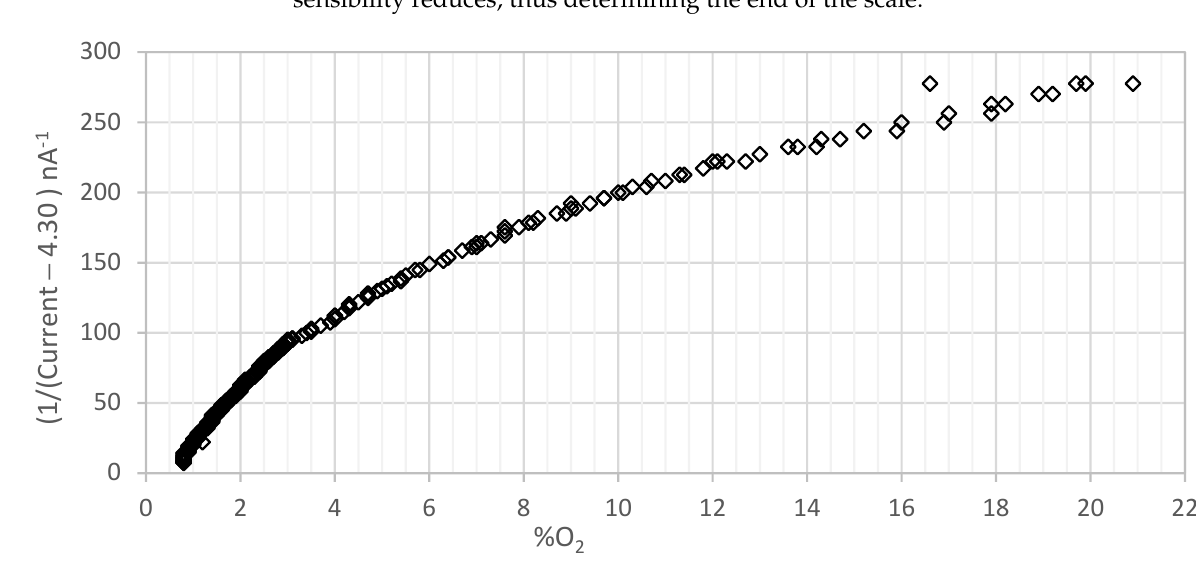
Figure 11. Inverse of the current intensity along the increase in oxygen concentration, in a gaseous environment, for the 363 ppm membrane with a thickness of 1.4 mm and THF. The 4.3 nA offset has been removed, and the inverse of the photodiode current is shown.